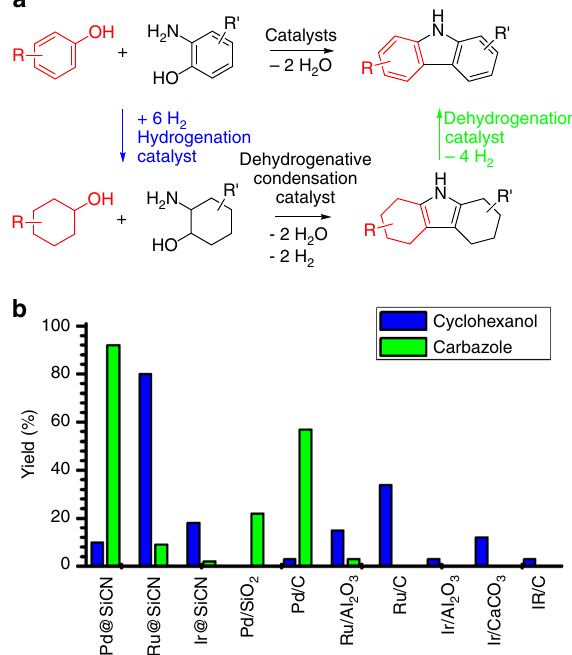
Fig. 1 Synthesis of aromatic N-heterocycles and polycyclic heteroaromatic compounds. a Known sustainable two-, three- and four-component reactions linking alcohols to important aromatic N-heterocyclic compounds. substituents). b Catalytic reaction of phenols and aminophenols or